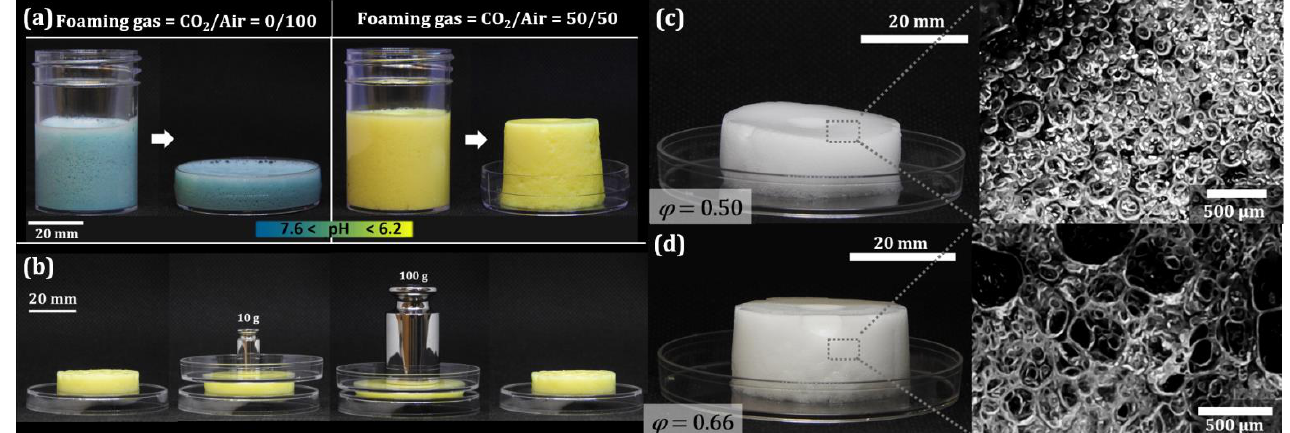
Figure 2. Foams obtained with different foaming gases: air ( a ( left )) vs. CO 2 /air = 50/50 ( a ( right ), b – d ). The foaming solution was a mixture of 1 wt% alginate, 0.02 M CaCO 3 , 2 wt% Disponil APG 425, and 5 × 10 −5 M bromothymol blue as a pH-indicator dye. The morphology of the gelled foams could be controlled via the gas fraction ϕ : ( c ) ϕ = 0.5; ( d ) ϕ = 0.66 (both foams generated without pH indicator for better optical contrast).